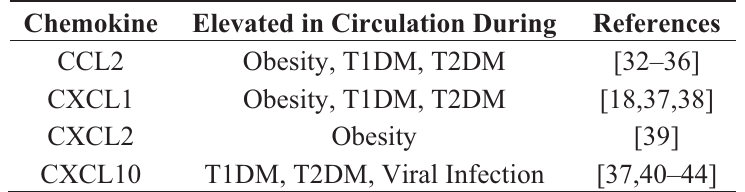
Table 2. Chemokines elevated in circulation during pathophysiological states.